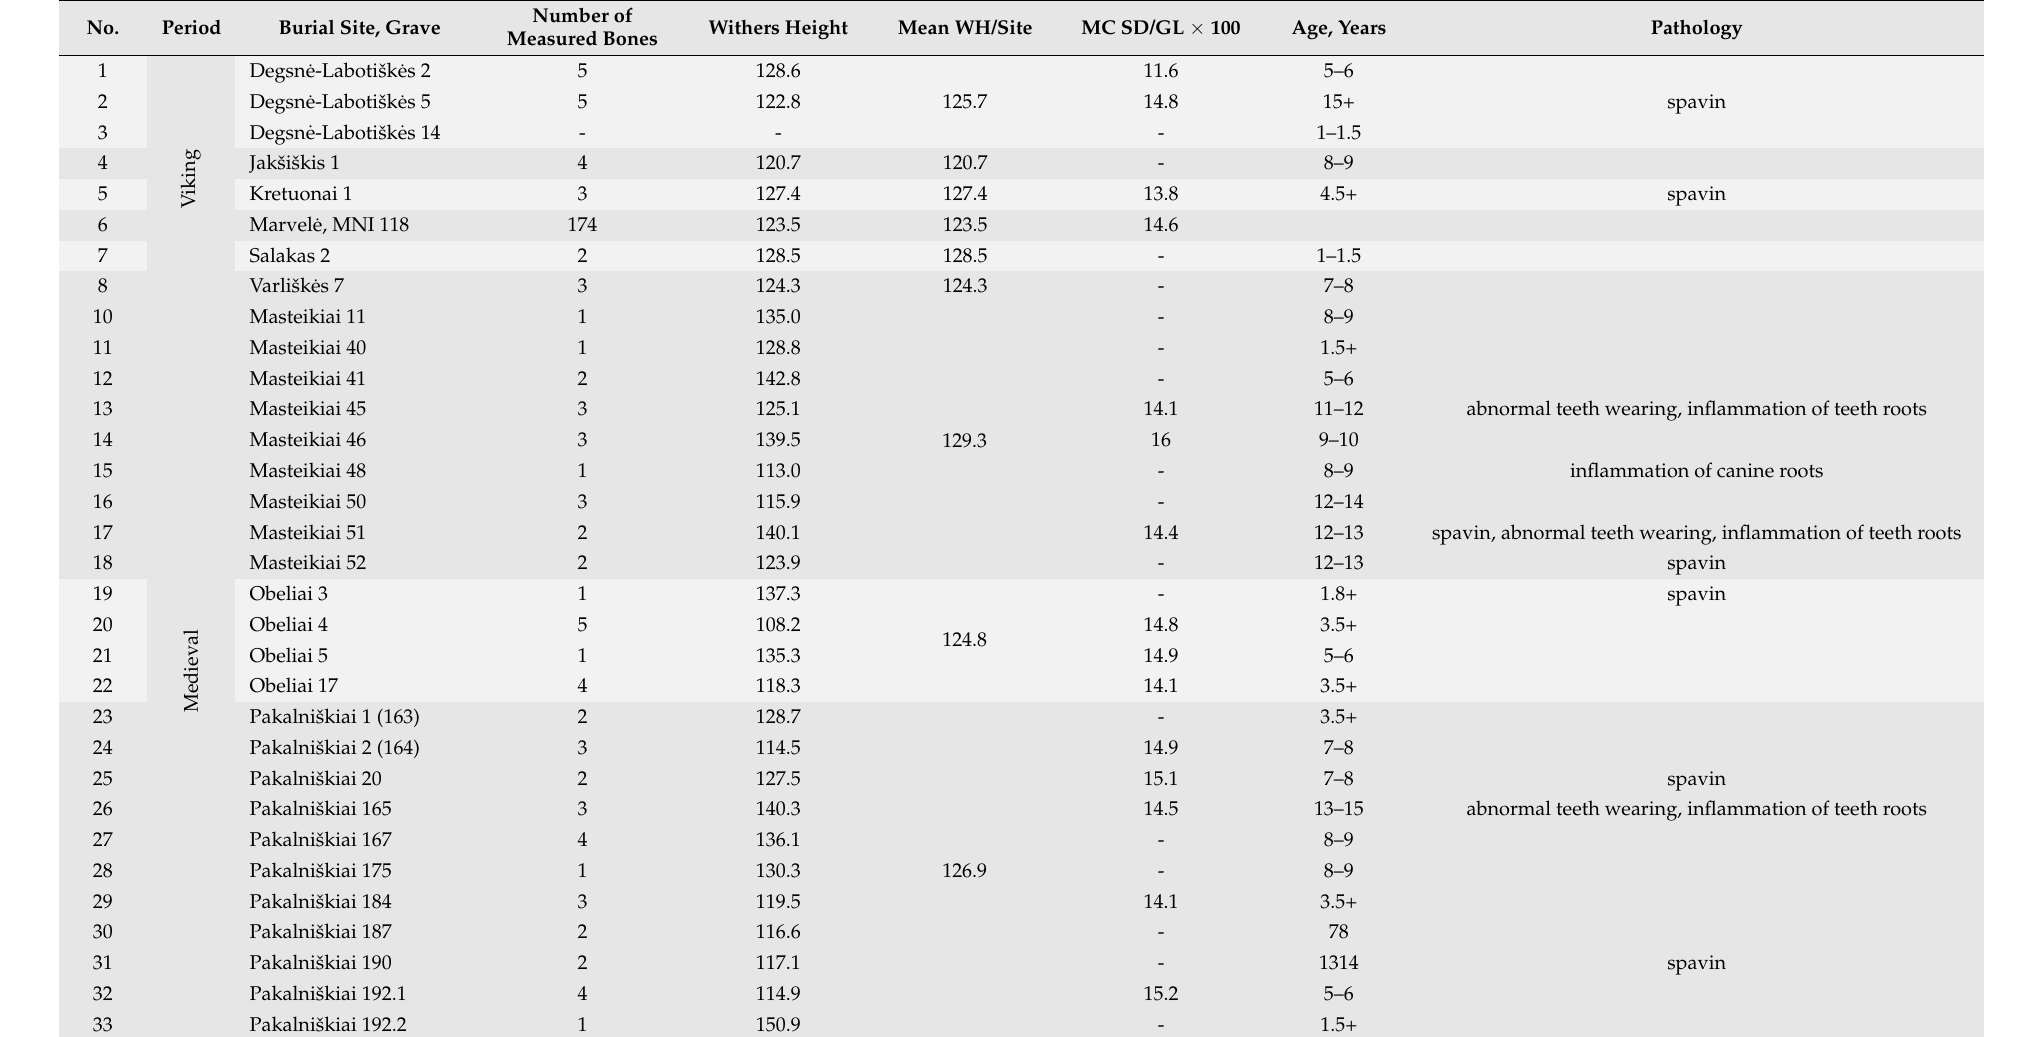
Table 2. Horses from the Viking and medieval period burial